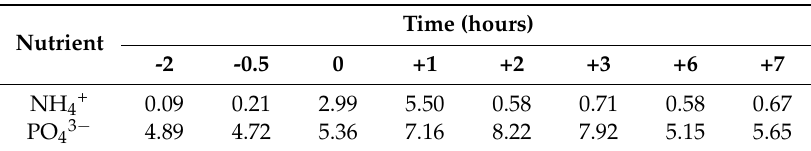
Table 4. Mean water column nutrient concentration as a percentage of depth-integrated (0–15 cm) sediment NH 4+ bio and PO 43 − bio concentrations during incubations. Negative times represent before, time 0 represents immediately prior to, and positive times represent hours after the sediment disturbance and resuspension event,